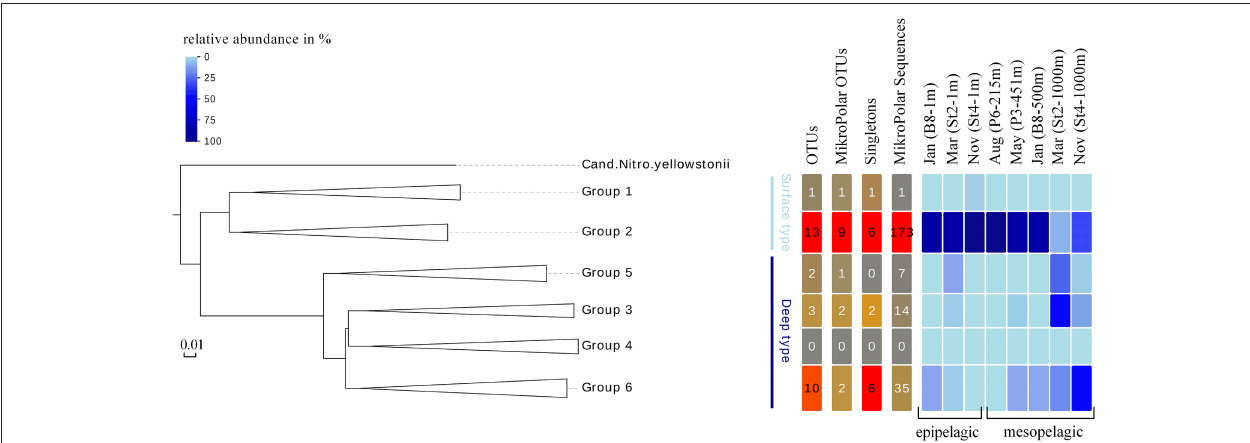
FIGURE 5 | Left panel Phylogenetic tree of 189 amoA OTUs at 97% sequence identity, representative of the genetic diversity of amoA clades 1-6 in reference samples (254 sequences) and in 10 MicroPolar samples (230 sequences). The colored lines indicates the grouping of the six amoA clusters in surface (light blue) and deep (dark blue) type. Right panel Distribution of OTUs, OTUs which only consist of MicroPolar sequences, OTUs that only consist of one sequence and MicroPolar sequences within the six amoA clusters. Heat map, in shades of blue, displaying the relative abundance of OTUs at each analyzed station and grouped by sampling